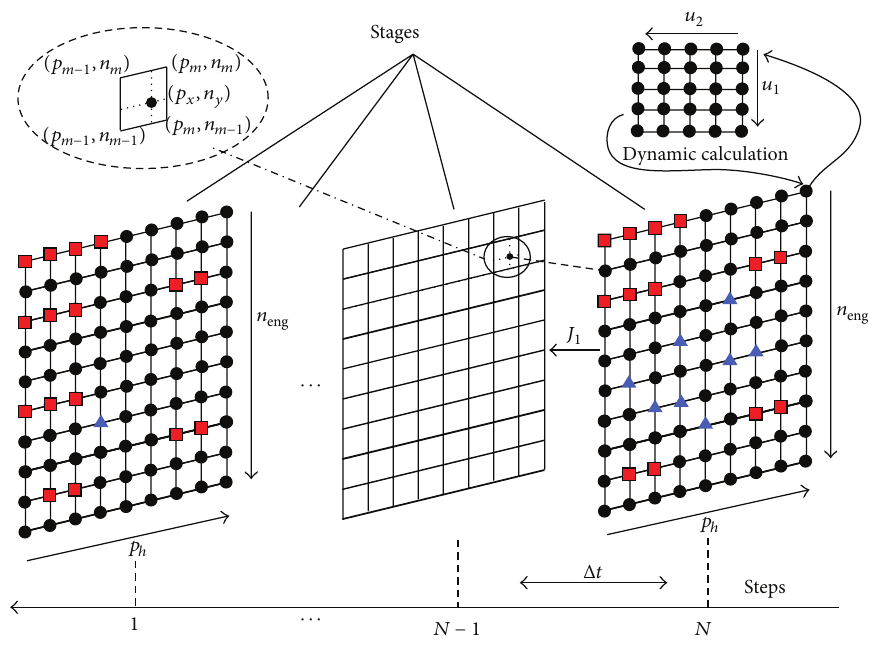
Figure 7: The detailed calculation process of the program.